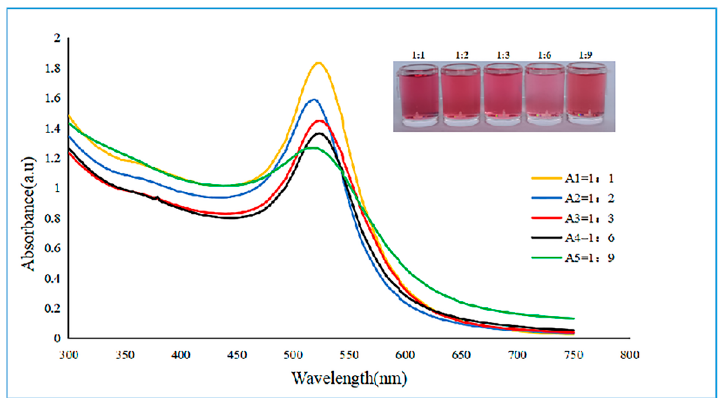
Figure 5. Ultraviolet–visible absorption spectra and colloid color diagram of gold nanoparticles prepared by different molar ratios of reactive substances.